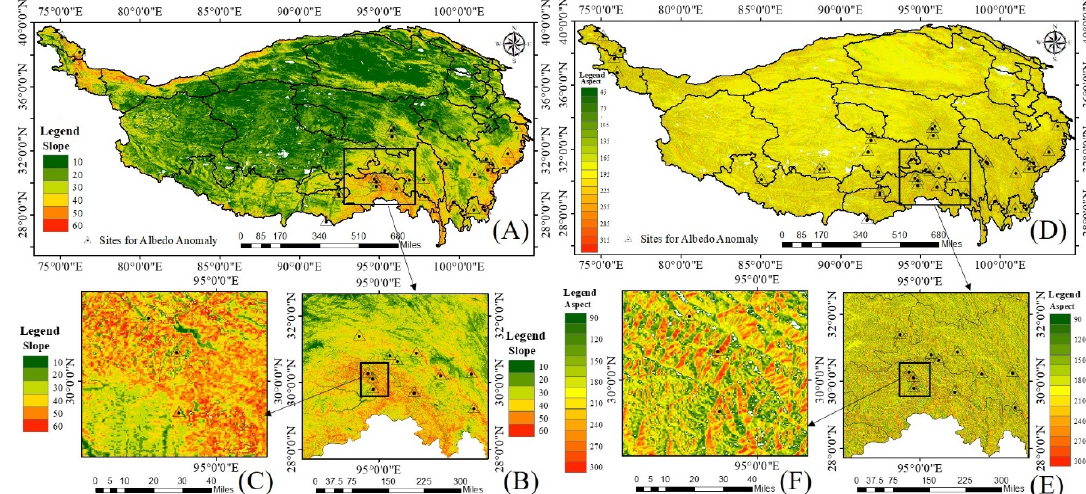
Figure 2. The topographic features in TP. ( A ) The slope of the TP, ( B ) details of a subarea in ( A ), ( C ) the slope of a selected site and its surroundings; ( D ) the aspect of the TP, ( E ) details of a subarea in ( D ), ( F ) the aspect of a selected site and its surroundings.